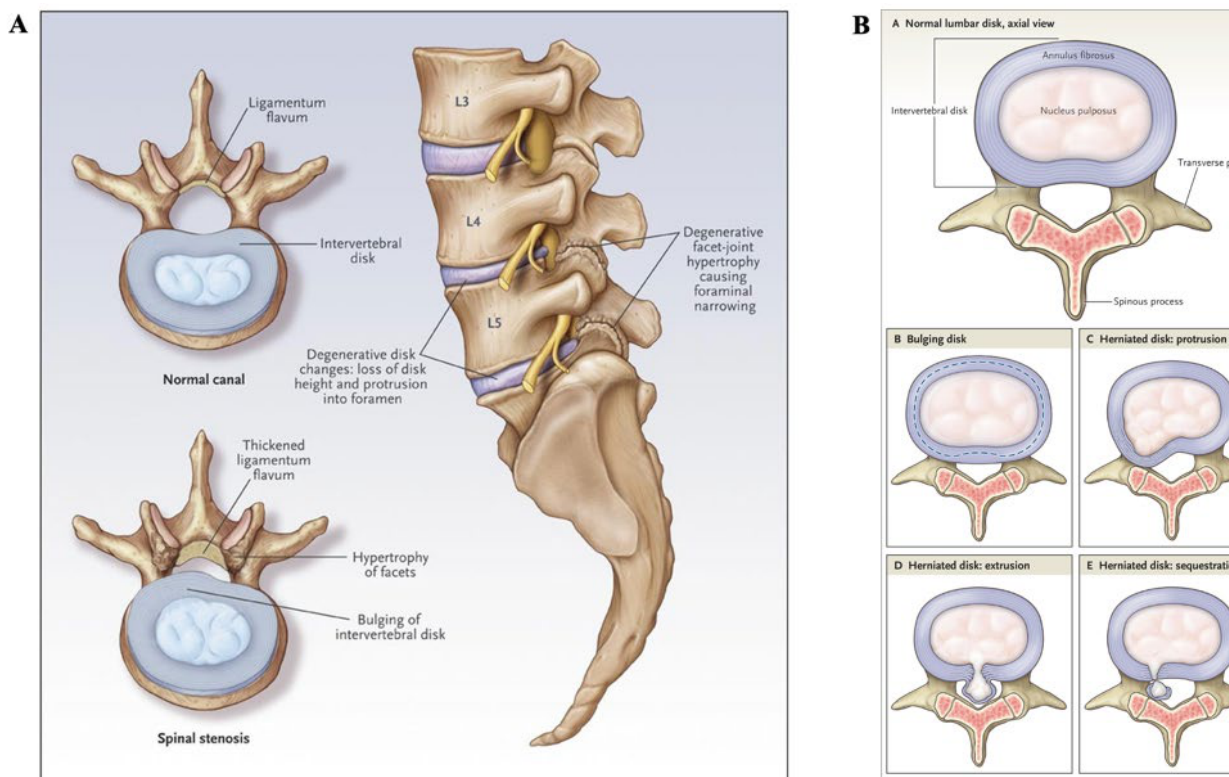
Figure 4. Characteristics of Lumbar Spinal Stenosis and Herniated Disks. ( A ) Axial views of the lumbar spine showing both normal anatomy and spinal stenosis. Depiction demonstrates intervertebral disk bulging, a thickened ligamentum flavum, and hypertrophied fact joints. Additionally, on sagittal view, there is loss of disk height and protrusion, and facet-joint osteoarthritis [44]. ( B ) Panel A demonstrates a non-displaced lumbar intervertebral disk. Panel B shows a bulging disk. Panel C demonstrates disk protrusion. Panel D demonstrates disk extrusion. Panel E demonstrates disk sequestration [45]. Adapted from Deyo et al. and Katz et al. [44,45].